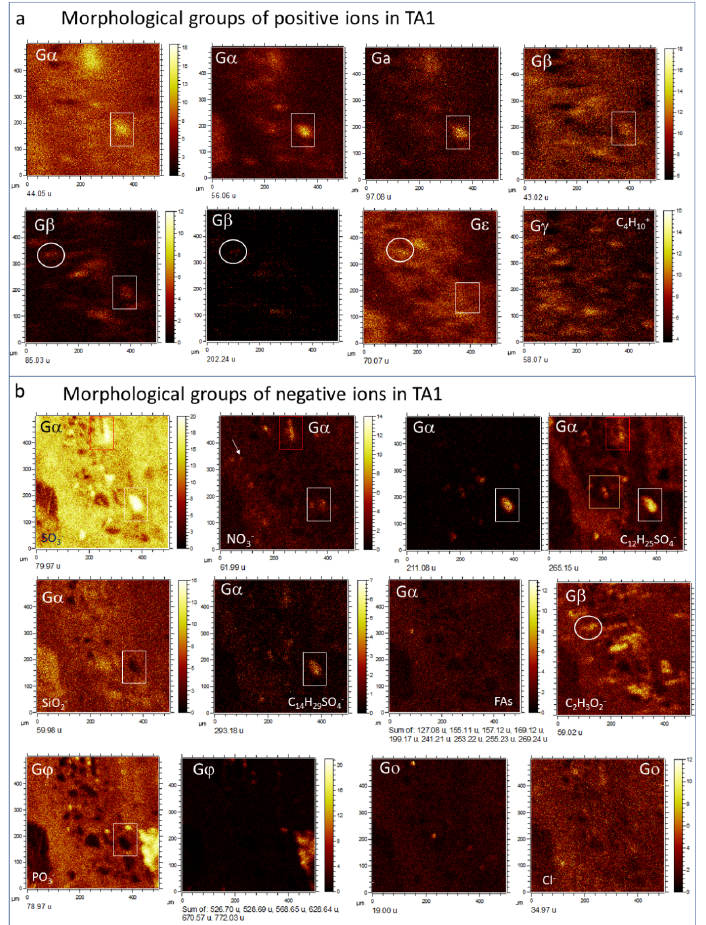
Figure 5. Characterization of the different morphological groups through the ToF-SIMS images in TA1. ( a ) Identification of four morphological groups (G α , G β , G ε , and G γ ) defined by the cation distribution. ( b ) Same as in ( a ) but using the anion distribution which allowed to recognize two additional groups (G φ , and G ο ). The white square points to the location of the SO 4 -rich clasts of the microbrecciated layer as a reference, while the white circular frame traces some straight microstructures that are not been previously identified. The ToF-SIMS images were obtained from a rasterized surface area of a 500 μ m square.